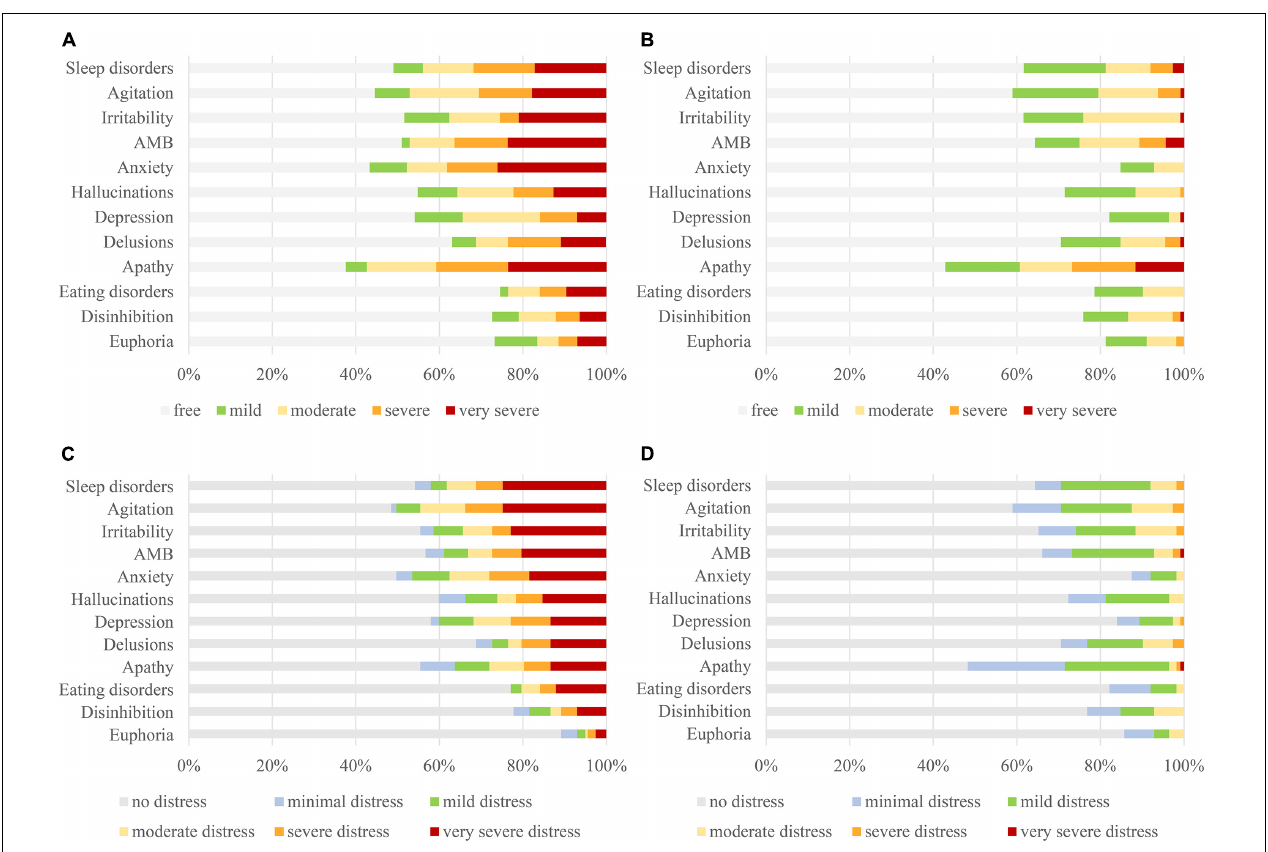
FIGURE 1 | Comparing severity levels of BPSD [ (A) : community; (B) : nursing home] and caregiver distress [ (C) : community; (D) : nursing home] between community and nursing home residents with dementia. BPSD, behavioral and psychological symptoms of